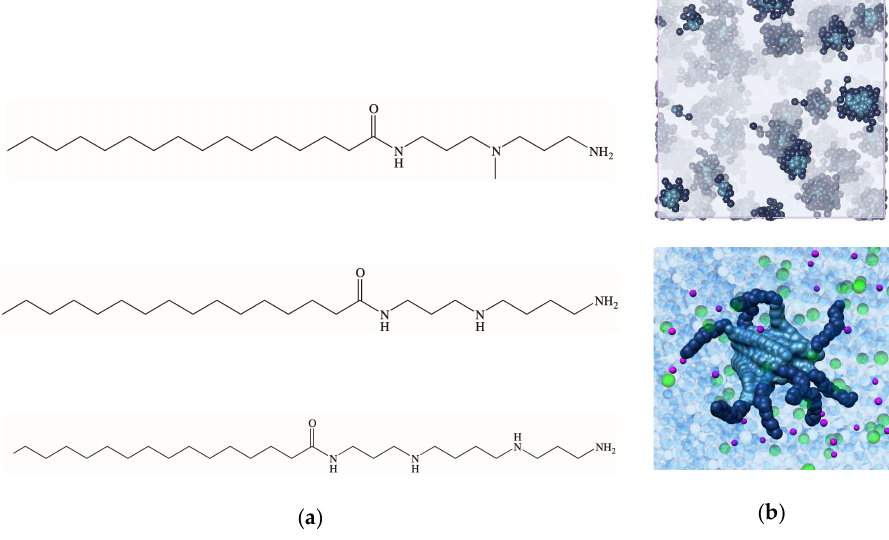
Figure 10. ( a ) Structures of C 16 G 0 (top), C 16 SPD (middle), and C 16 SPM (bottom) amphiphilic dendrons. At physiological pH, the former two dendrons bear 2 positive charges while C 16 SPM has a charge of + 3. ( b ) Mesoscale (top) and atomistic (bottom) structures C 16 SPM self-assembled dendrimers. The hydrophobic micellar core is shown as steel blue spheres while the hydrophilic SPM residues are portrayed as navy blue spheres. In the top panel, the solvated environment is shown as a light gray field. In the bottom panel, water molecules are represented as transparent light blue spheres, with some Na + and Cl − ions shown as pink and green spheres, respectively. Adapted from [22] with the permission of The Royal Society of